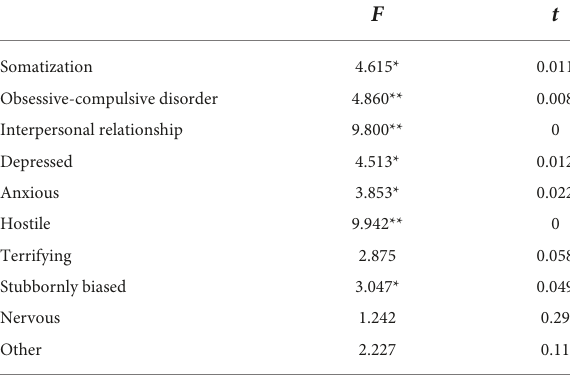
Statistical analysis results from Figure 10 and Table 4 :